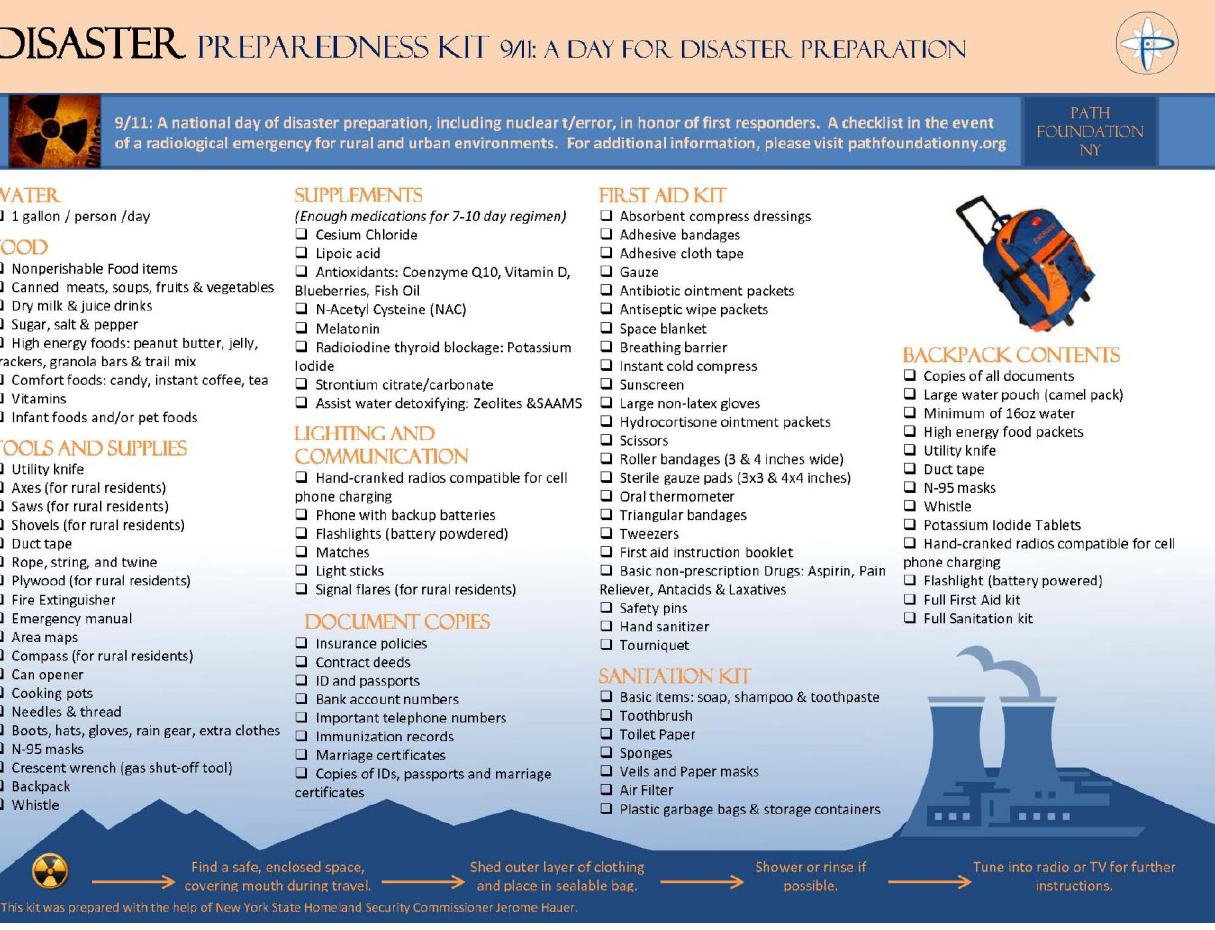
Figure A1. Disaster preparedness